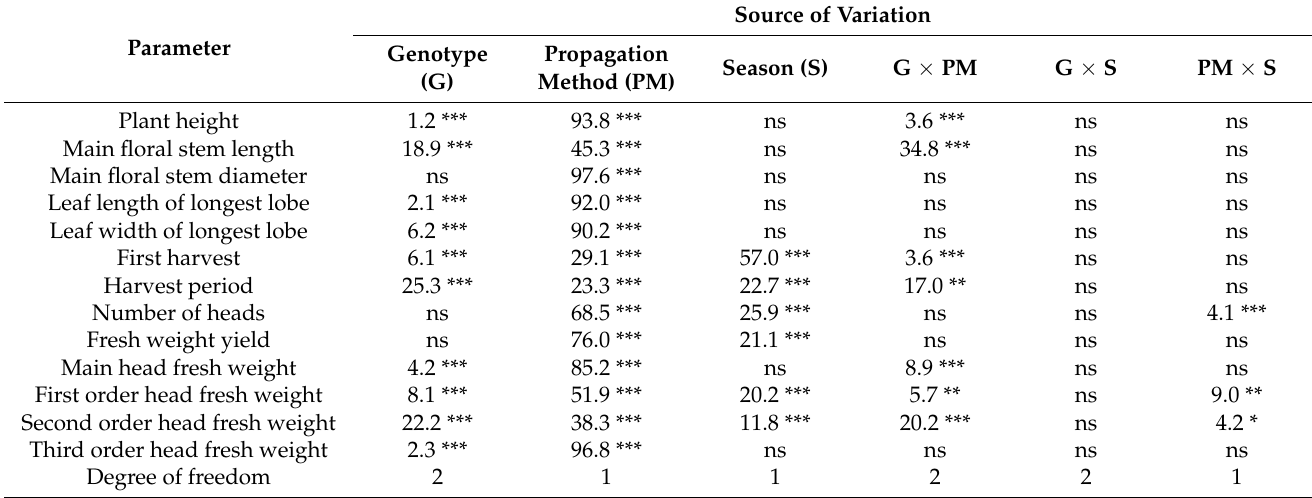
Table 1. Mean square per each source of variation (percentage of total) resulting from analysis of